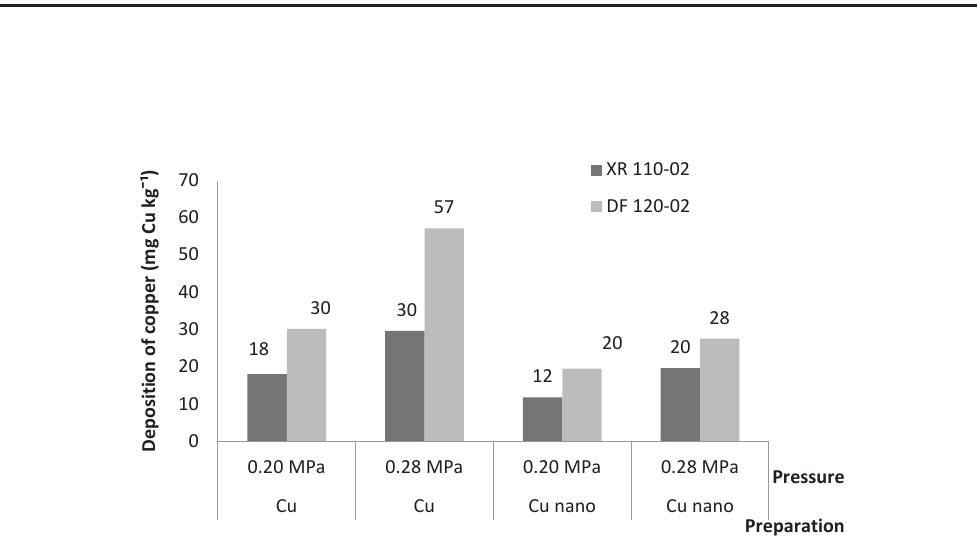
Fig.3. The deposit of copper on rape plants at the development phase of 6 leaves (16 BBCH) for the studied nozzles (flat fan XR 110-02 and double flat fan DF 120-02) at the pressure of 0.20 and 0.28 MPa. Cu – fertilizer was Mikrovit Copper 80, Cu nano – contained nano copper.